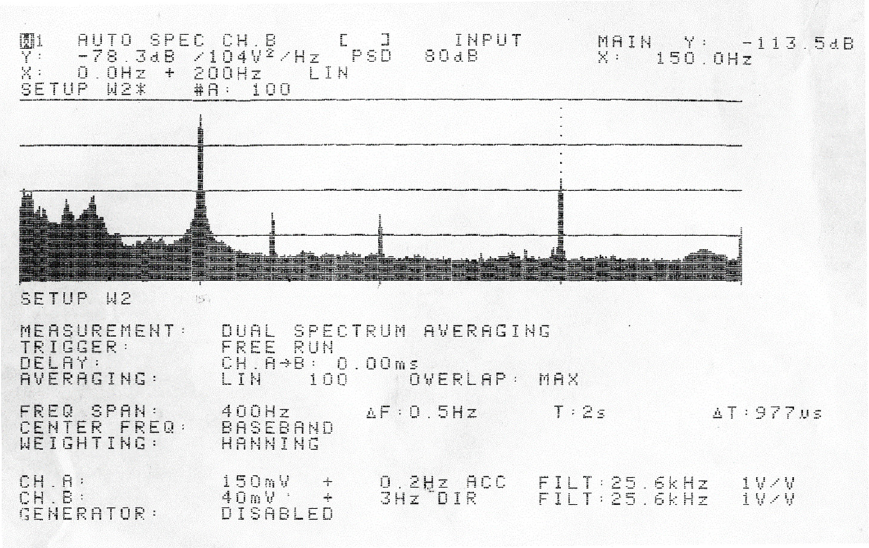
Figure 6. Singular value decomposition of the spectral density matrices for cantaloupe fruit. 3. Results and Discussion 3.1. Impact Testing Impact height testing is important to determine the height at which specimens are damaged during processing operations. The impact heights used to study the bruises at different surfaces and heights of 10, 20, 30, and 40 cm for the cantaloupe specimens are shown in Figure 7.